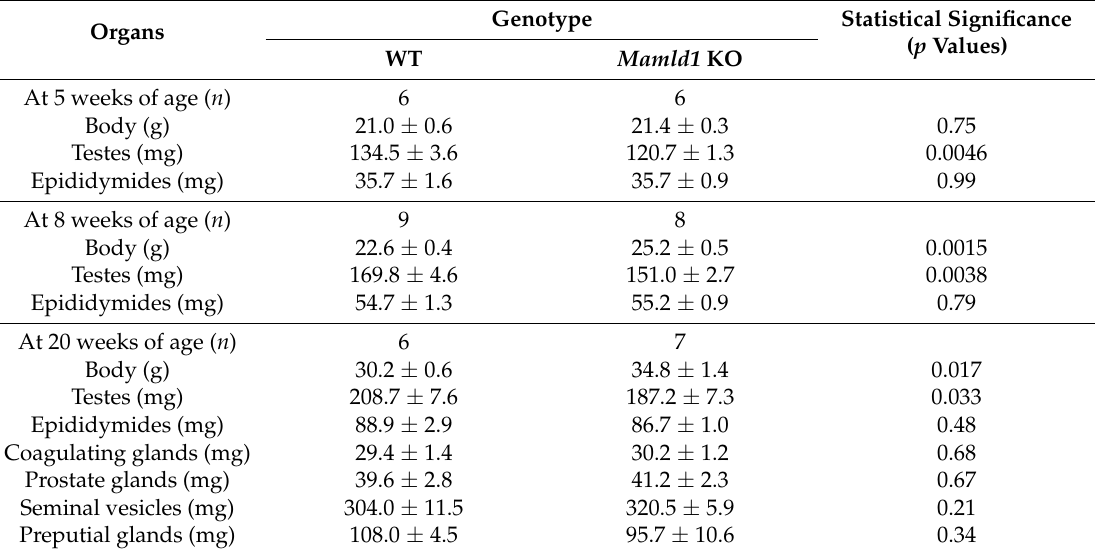
Table 1. Weight of reproductive organs of mice at 5, 8 and 20 weeks of